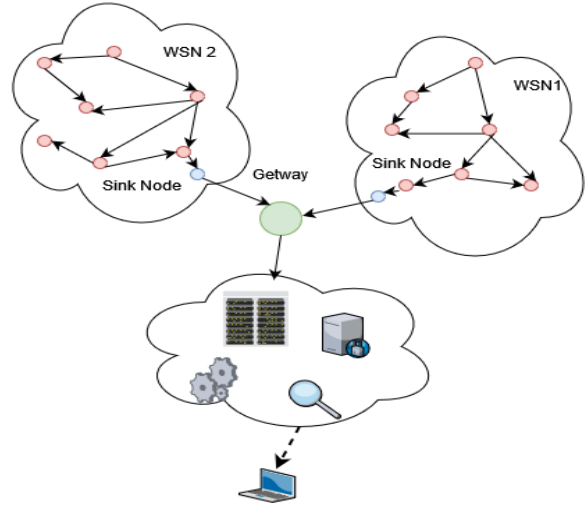
Figure 3. Typical WSN